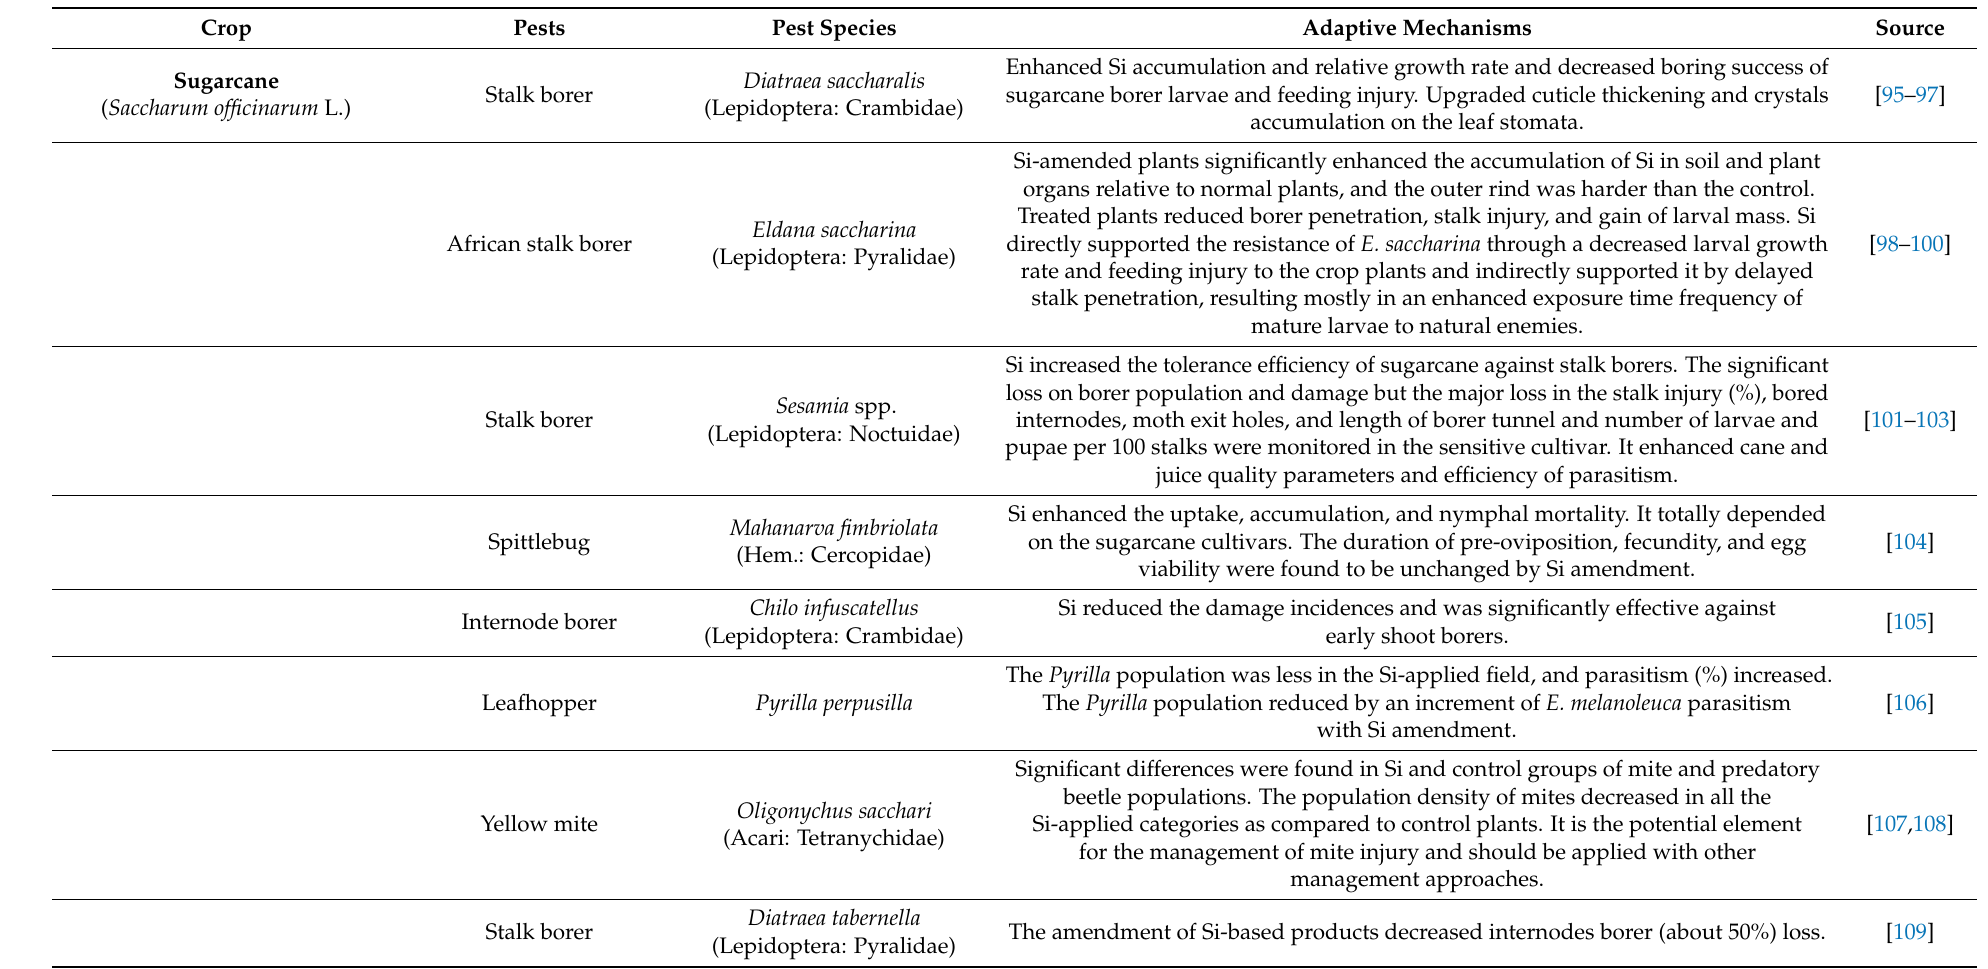
Table 1. Effects of silicon on plant pests and related resistance